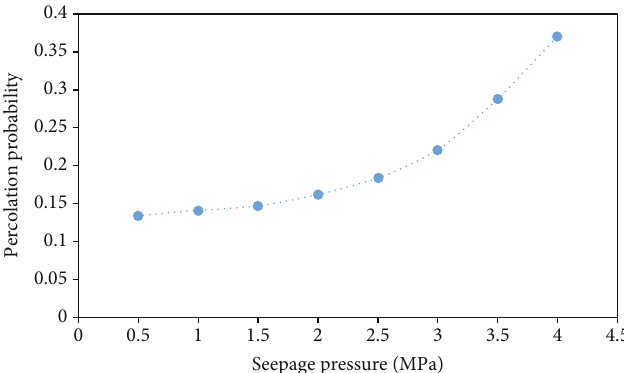
Figure 13: Variation of percolation probability with seepage